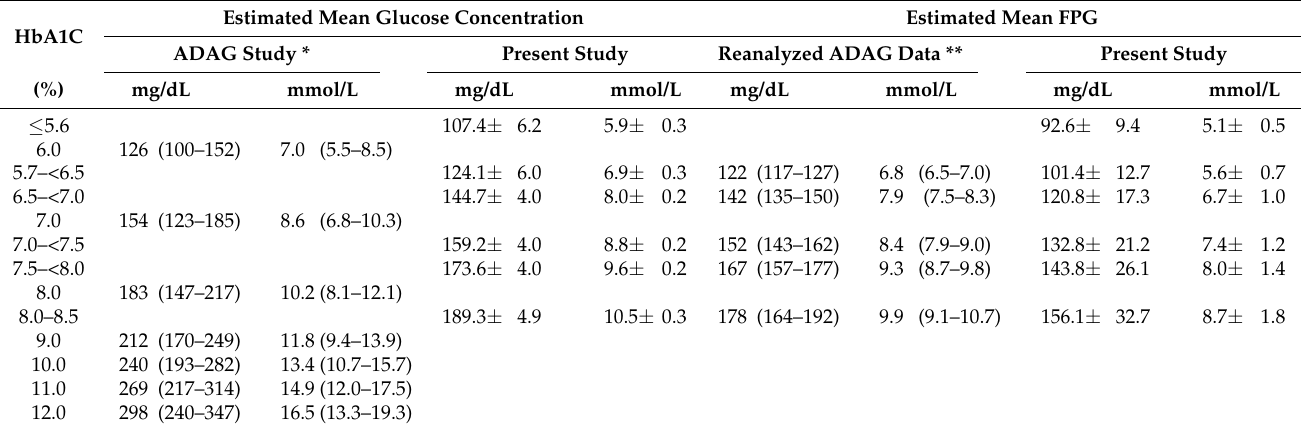
Table 2. Mean glucose levels for specified HbA1c levels from the present study and A1c-derived average glucose (ADAG)